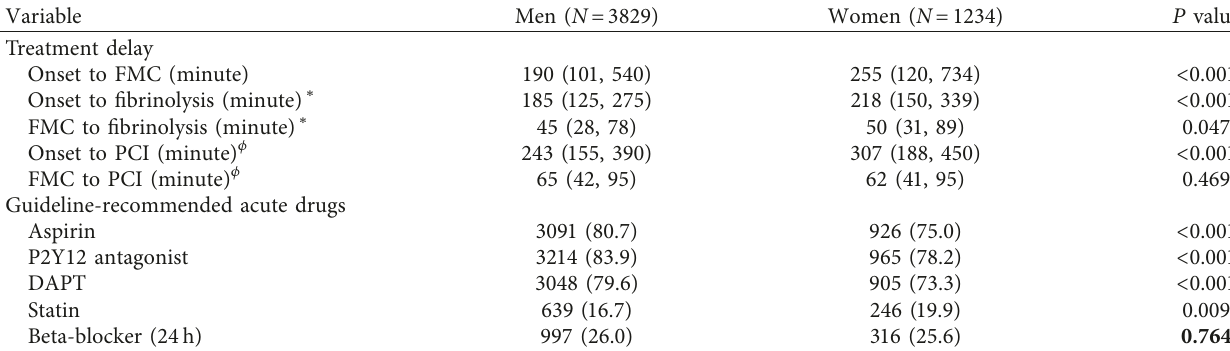
Table 2: Treatment delay and use of guideline-recommended acute drugs between the study groups.